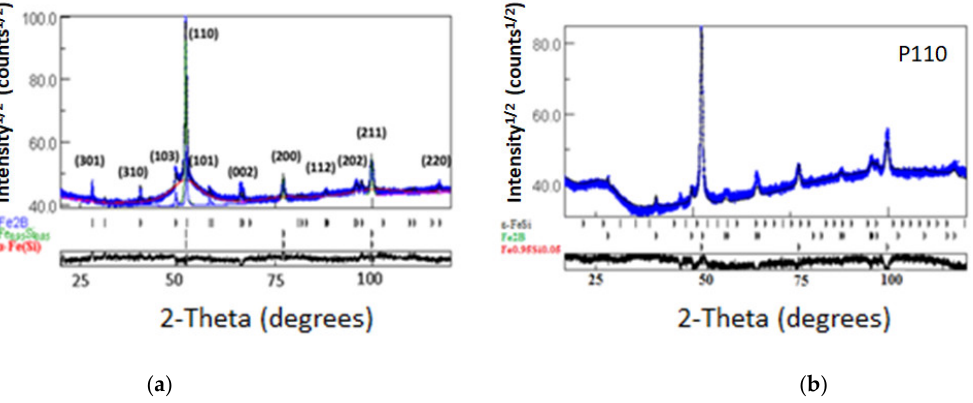
Figure 3. Rietveld refinement of the XRD patterns of ( a ): the initial powder; and ( b ): laser melted P110 sample. Table 2. Phases, lattice parameters ( a , c ), relative deviations ( ∆ a , ∆ c ), and crystallite sizes deduced from the XRD Rietveld